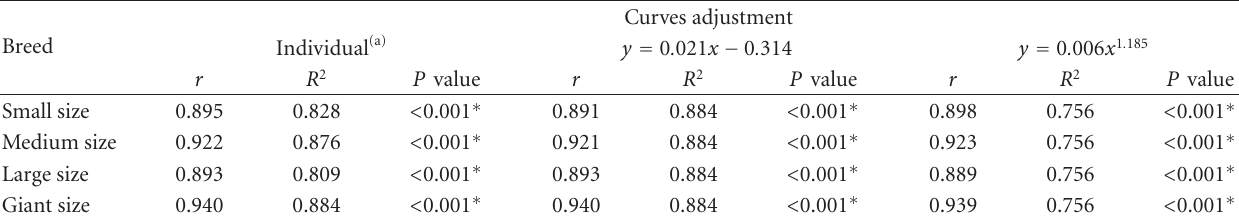
Table 3: Comparison between expressions of curves adjustment determined with regard to placenta thickness for the studied breeds. Curves adjustment Breed Individual